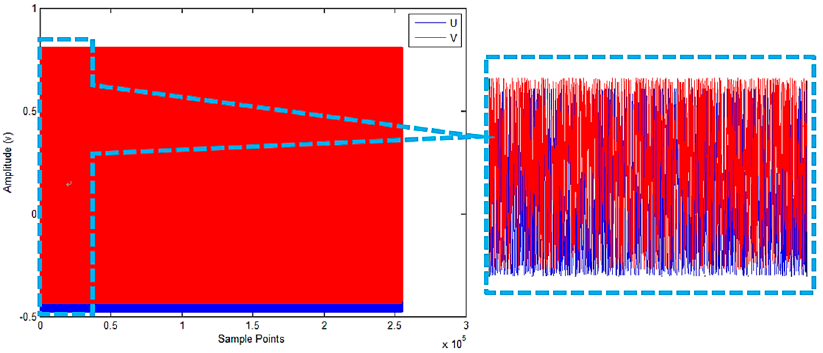
Figure 17. Shuffled experimental signal data.